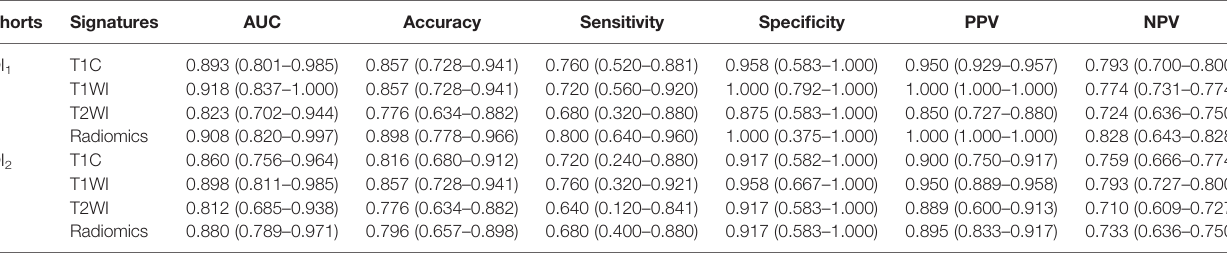
TABLE 2 | Performance of texture signatures in differentiating the growth hormone pituitary adenoma